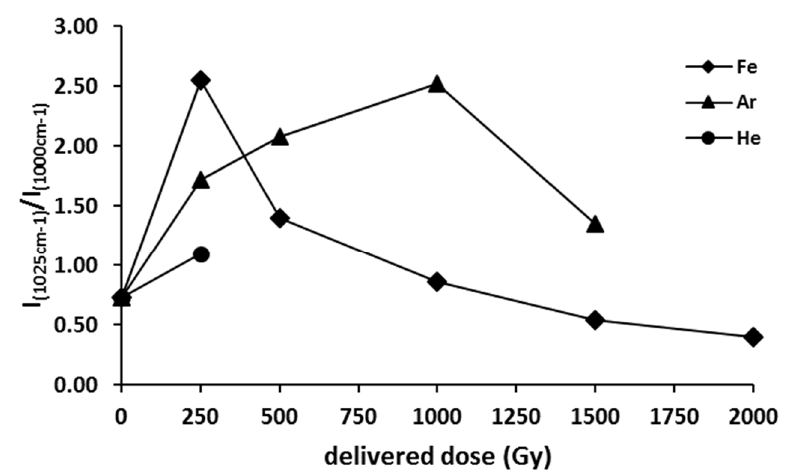
Figure 5. Effect of HZE irradiation on the ratio between Ca 2+ -DPA (1025 cm − 1 ) and phenylalanine (1000 cm − 1 ) SERS mode intensities (I 1025 cm − 1 /I 1000 cm − 1 ) of P. thermantarcticus